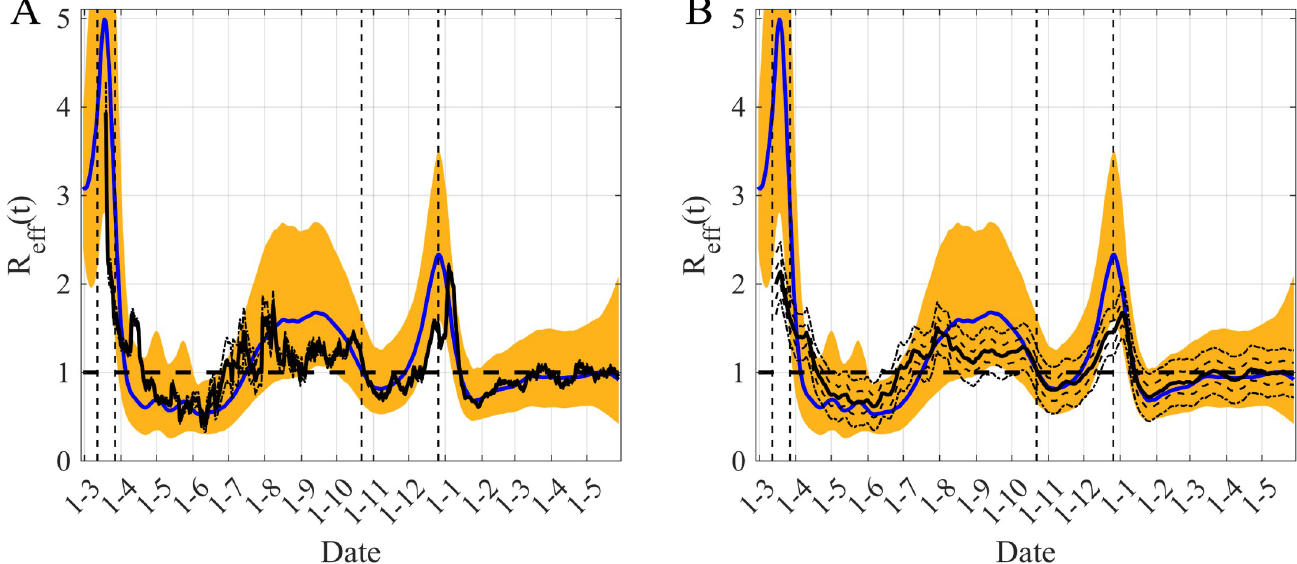
Fig 5. Comparison between our R estimation and those obtained with two other methods based on Irish multiple datasets. A/ Comparison with the eff (t) method implemented in EpiEstim R package (http://metrics.covid19-analysis.org/). B/ Comparison with the method proposed by Arroyo-Marioli et al [28] (http:// trackingr-env.eba-9muars8y.us-east-2.elasticbeanstalk.com/). Blue lines are the median of the posterior of our estimates of R and orange areas are the eff (t) corresponding 95% CI of our R eff estimates. The black lines represent the median of R eff (t) for the other methods and the black dotted-dashed lines delimit the corresponding 95% CI associated. In B/ the black dashed lines delimited the 65% CI. The vertical black dashed lines correspond to the start dates of the main mitigation measures. The horizontal dashed-line is the threshold R = eff